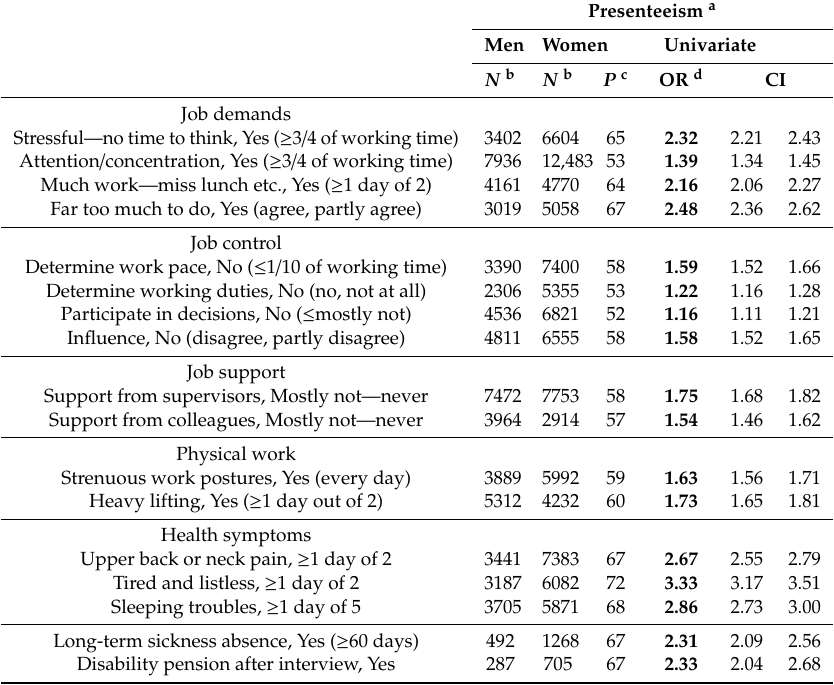
Table 2. Number of individuals, prevalence, and odds ratios (ORs) of presenteeism (two times or more) with 95% confidence intervals (CIs), related to psychosocial and physical work factors, health symptoms, long-term sickness absence, and disability pension, interviewed 2001–2013 a